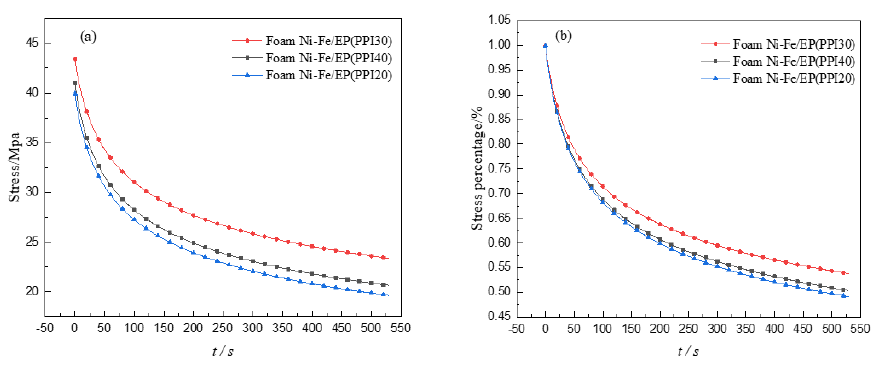
Figure 9. Curves of stress relaxation ( a ) and their percentage of stress relaxation ( b ).